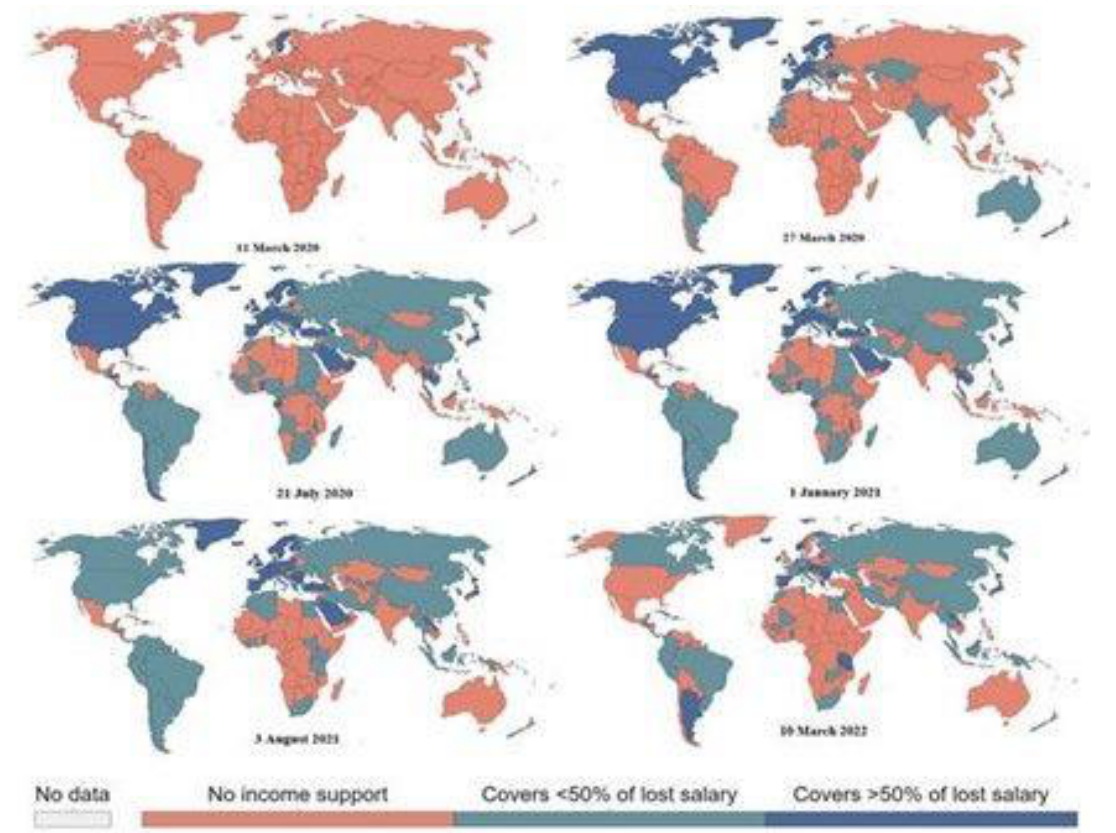
Figure 2. Income support during the COVID-19 pandemic. Source: Authors’ calculations based on the OxCGRT. https://ourworldindata.org/covid-income-support-debt-relief (accessed on 15 April 2022).